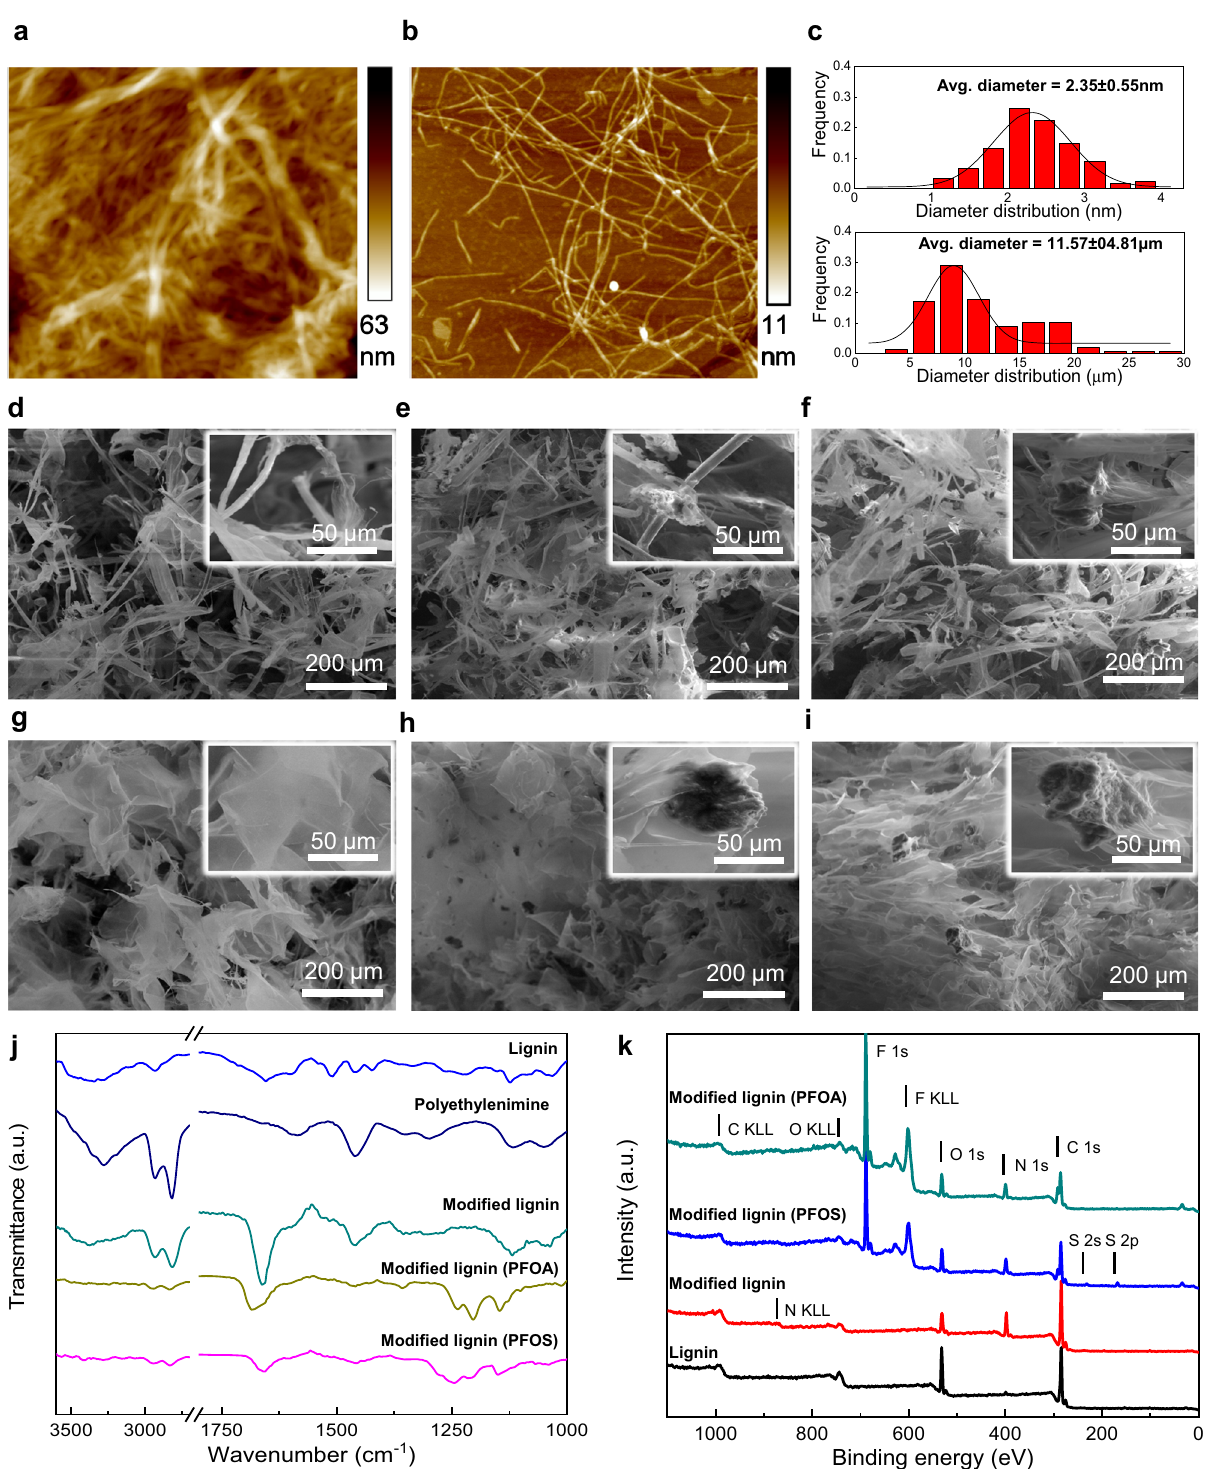
Fig. 2 The characterization of the bioinspired composite materials and their components. a The AFM image of cellulose fi bers. b The AFM image of cellulose nano fi brils. c , The average diameter estimates of cellulose fi bers and cellulose nano fi brils. d The typical SEM image of cellulose fi bers, e The typical SEM image of cellulose fi ber/lignin composite. f The typical SEM image of cellulose fi ber/modi fi ed lignin composite. g The typical SEM image of cellulose nano fi brils. h The typical SEM image of cellulose nano fi bril/lignin composite. i The typical SEM image of RAPIMER composite. j The FTIR spectra of lignin, polyethylenimine, modi fi ed lignin, and modi fi ed lignin after PFAS adsorption. The top light blue line: lignin, the second top dark lune line: polyethylenimine, the third green line: modi fi ed lignin, the fourth yellow-green line: PFOA adsorbed modi fi ed lignin, the bottom purple line: PFOS adsorbed modi fi ed lignin. k The XPS spectra of different lignin, modi fi ed lignin, and modi fi ed lignin after PFAS adsorption. The top green line: PFOA adsorbed modi fi ed lignin. The second blue line: PFOS adsorbed modi fi ed lignin. The third red line: modi fi ed lignin. The bottom black line: lignin. For SEM images, the experiment was reproduced n = 3 times.The Source data is provided as a Source Data fi